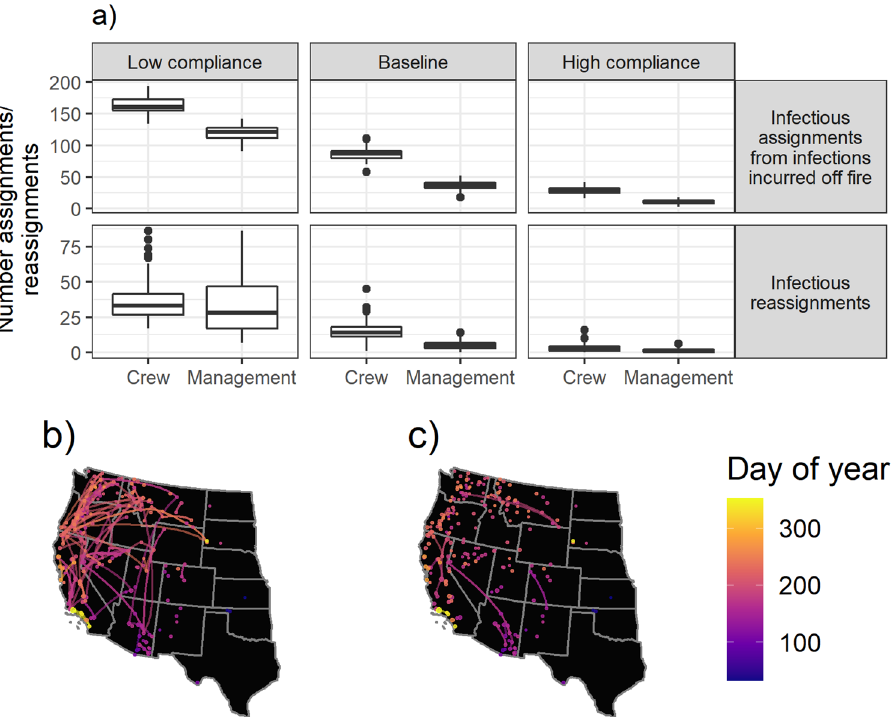
Figure 5. ( a ) The number of infectious assignments and reassignments by scenario and personnel type for the 2017 fire assignment data. ( b ) A map of the infectious reassignments that occurred during the Low Compliance run using 2017 data that had the highest number of infectious reassignments (i.e., the worst case scenario observed). ( c ) A map of the infectious reassignments that occurred during the High Compliance run using 2017 data that had the highest number of infectious reassignments. All large fires included in the analysis are mapped as points, with the point size corresponding to the maximum number of personnel assigned to the fire on a single day. Lines connecting fires indicate infectious reassignments.